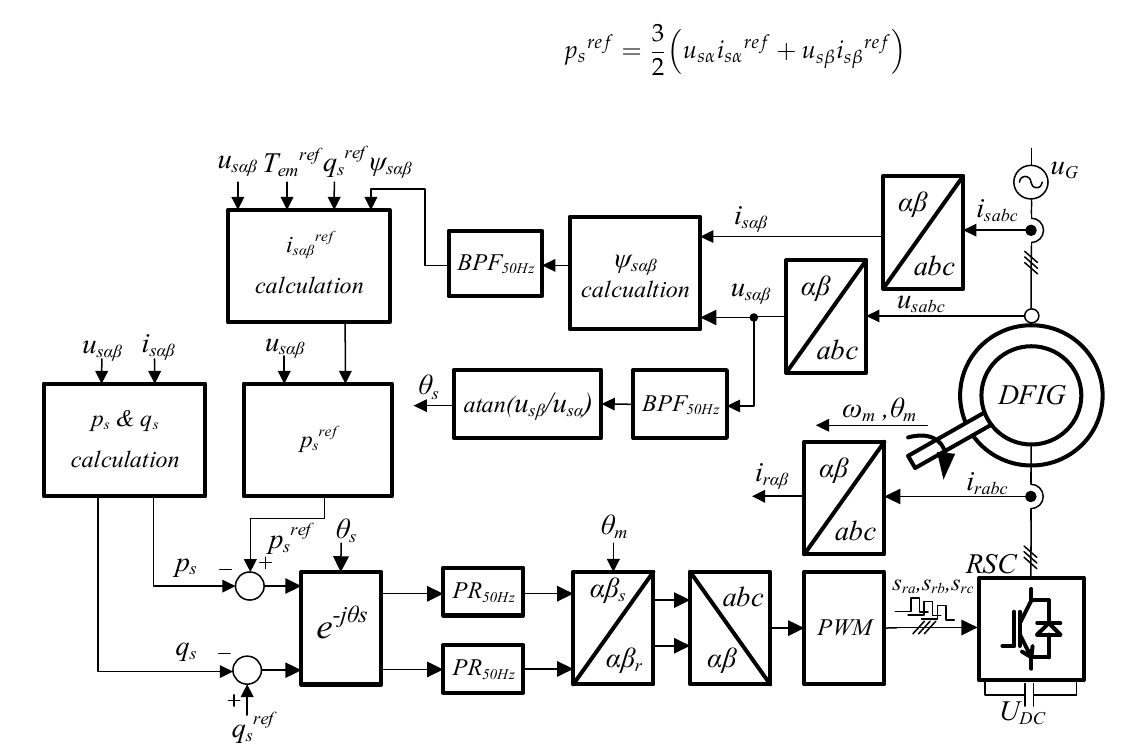
Figure 5. Direct power control of DFIG in the orthogonal stationary frame.